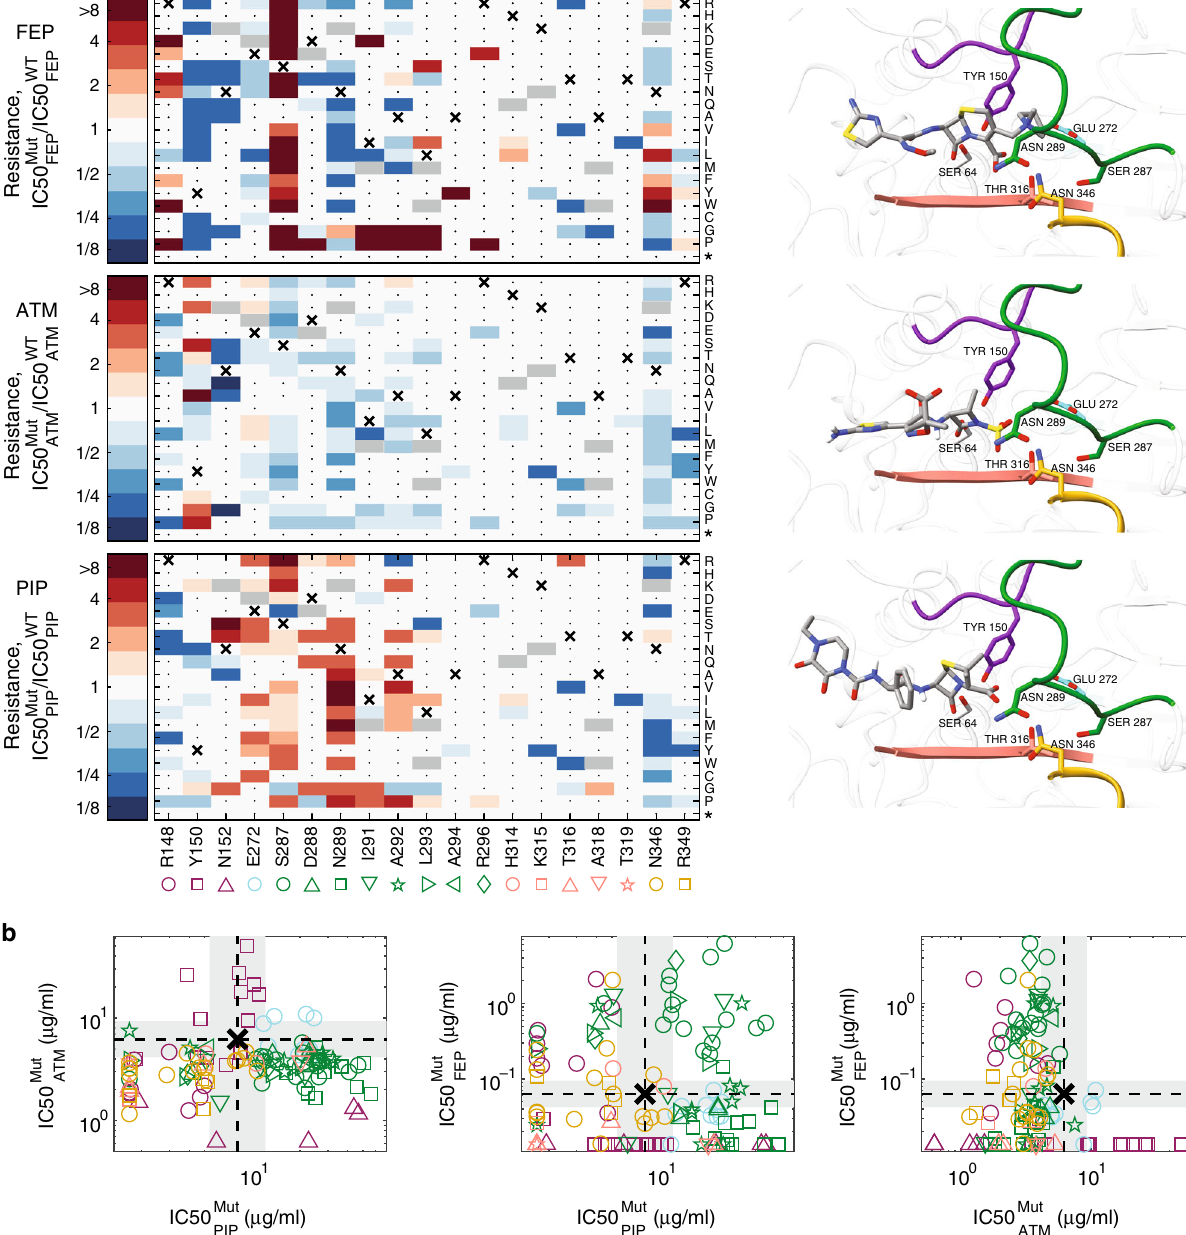
Fig. 3 Mutations that confer resistance to one drug are often sensitizing to other drugs. a For each of the 122 identi fi ed mutants we calculated resistance to FEP, AZT, and PIP as the drug concentration that inhibits mutant growth, IC 50 Mut , divided by that of the WT IC 50 WT . The WT amino acid is marked with AB AB an X and mutations, which were not included in our design are marked in gray. Mutations which did not confer resistance to any drug were not enriched and could not be identi fi ed in our data are marked with a dot. The resistance level of the latter to all drugs is expected to be similar to the WT or smaller. Source data are provided as a Source Data fi le. b The inhibitory concentration of each mutant is plotted on a logarithmic scale for the different drugs to assess cross-resistance. WT inhibitory concentration is marked with a dashed line and a gray background represents our resolution as determined by drug dilution factor between measurements. c The predicted conformation of the three antibiotics within the Bla ampC pocket. The antibiotics were docked using AutoDock Vina to the 3D crystal structure of Bla ampC beta-lactamase (PDB 1KVL) with the S64G replacement to emulate the WT physico-chemical environment. The enzyme is shown in ribbon, and regions that contain residues that affect resistance are colored in the same colors as in 3a-b. Residues for which multiple substitutions confer antibiotic resistance are highlighted and shown in stick representation. Antibiotics are colored-coded by atoms (gray for C, red for O, blue for N, yellow for S, and white for beta-lactam drugs and to a beta-lactamase inhibitor. Our mea- amino-acid change in the beta-lactamase enzyme Bla ampC can surements show that such escape mutations appear only for some confer resistance levels exceeding the native concentration that drug-inhibitor combinations, most prominently for FEP-AVI the wild-type can sustain without the inhibitor. In contrast, we and ATM-AVI, and are rare and drug-speci fi c. In these evolu- identi fi ed no single amino-acid mutants which escapes the tionary susceptible drug-inhibitor combinations, even a single piperacillin-avibactam tradeoff.